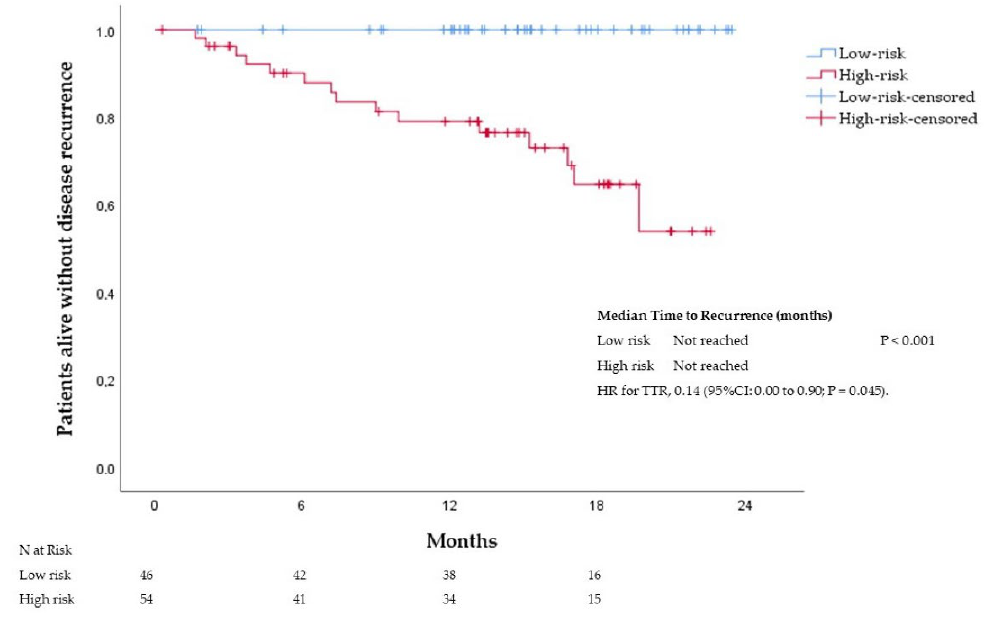
Figure 4. Time to recurrence according to risk groups in the validation cohort.